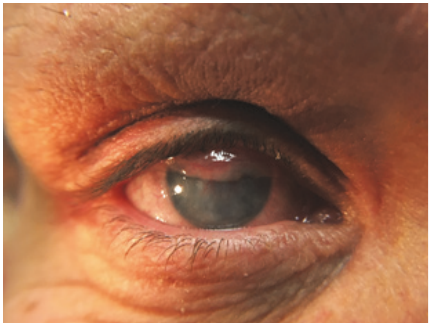
Figure 2: Corneal ulcer after Cryo treatment and conjunctival